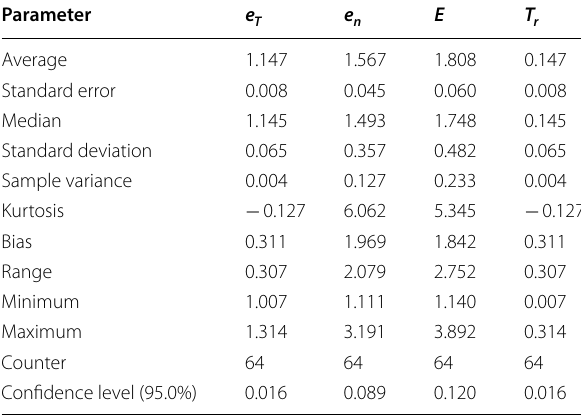
Table 8 Results of the calculations for LPG, I and II